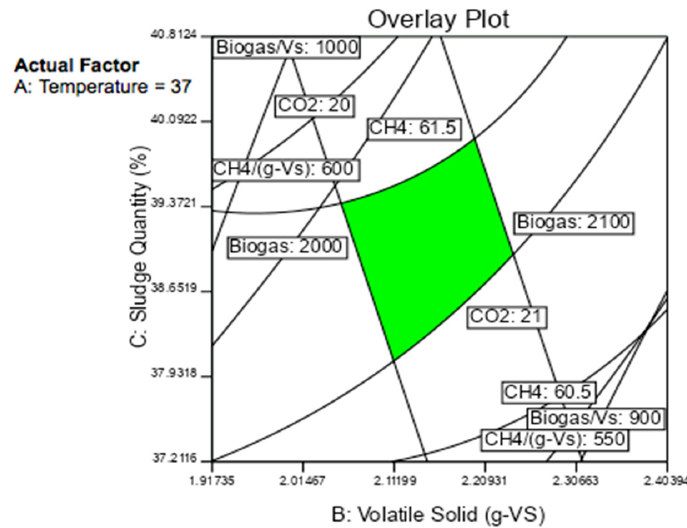
Figure 20. Overlay plot based on the second criterion.